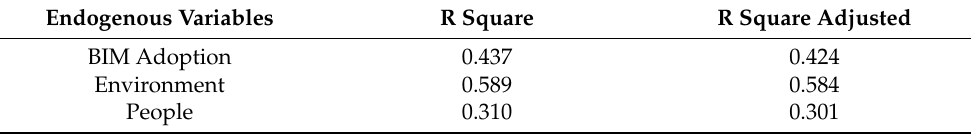
Table 8. Result of R-square.